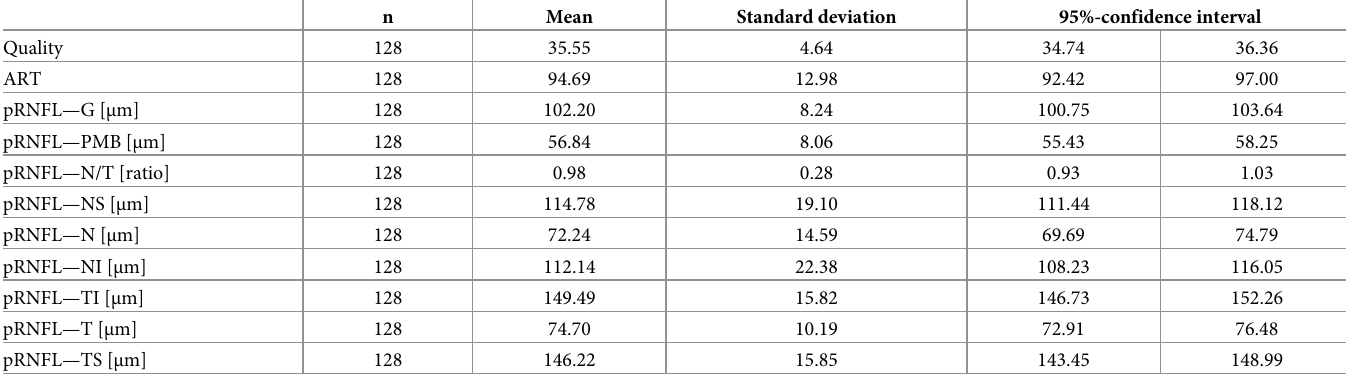
Table 4. Peripapillary RNFL measurements.